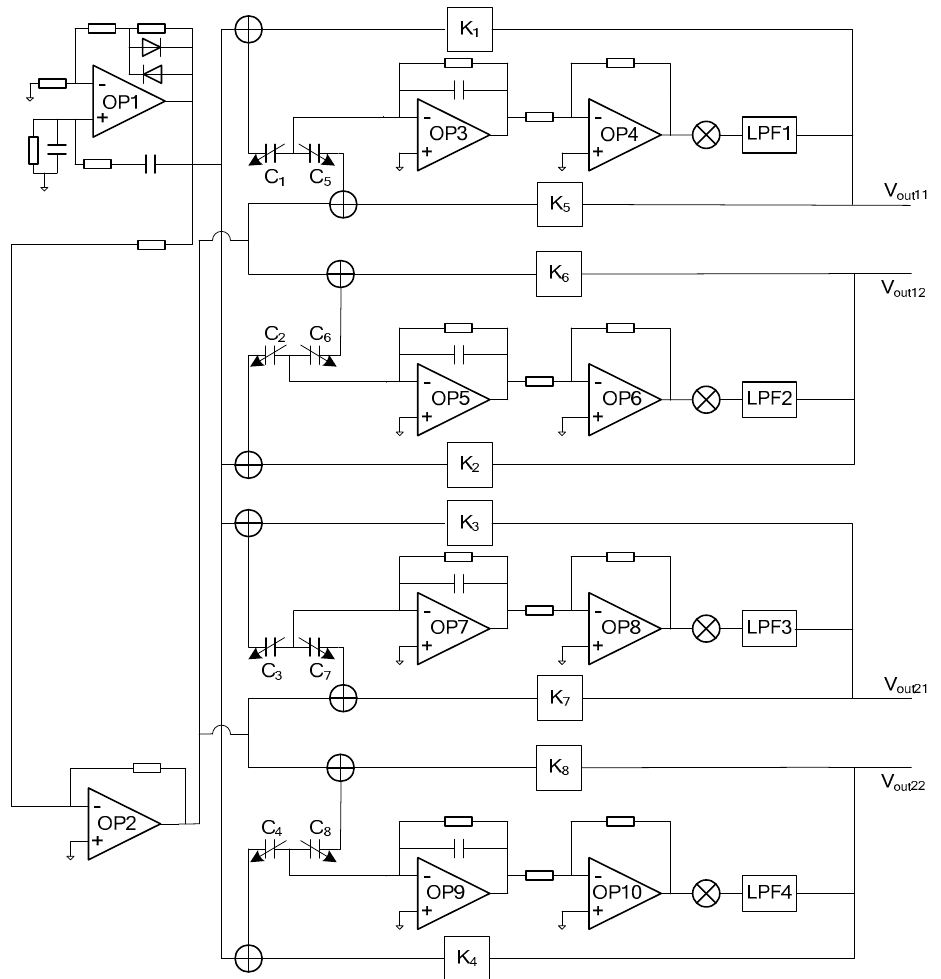
Figure 6. Overall realization scheme for the interface ASIC of micro gyroscope with ball-disc rotor .